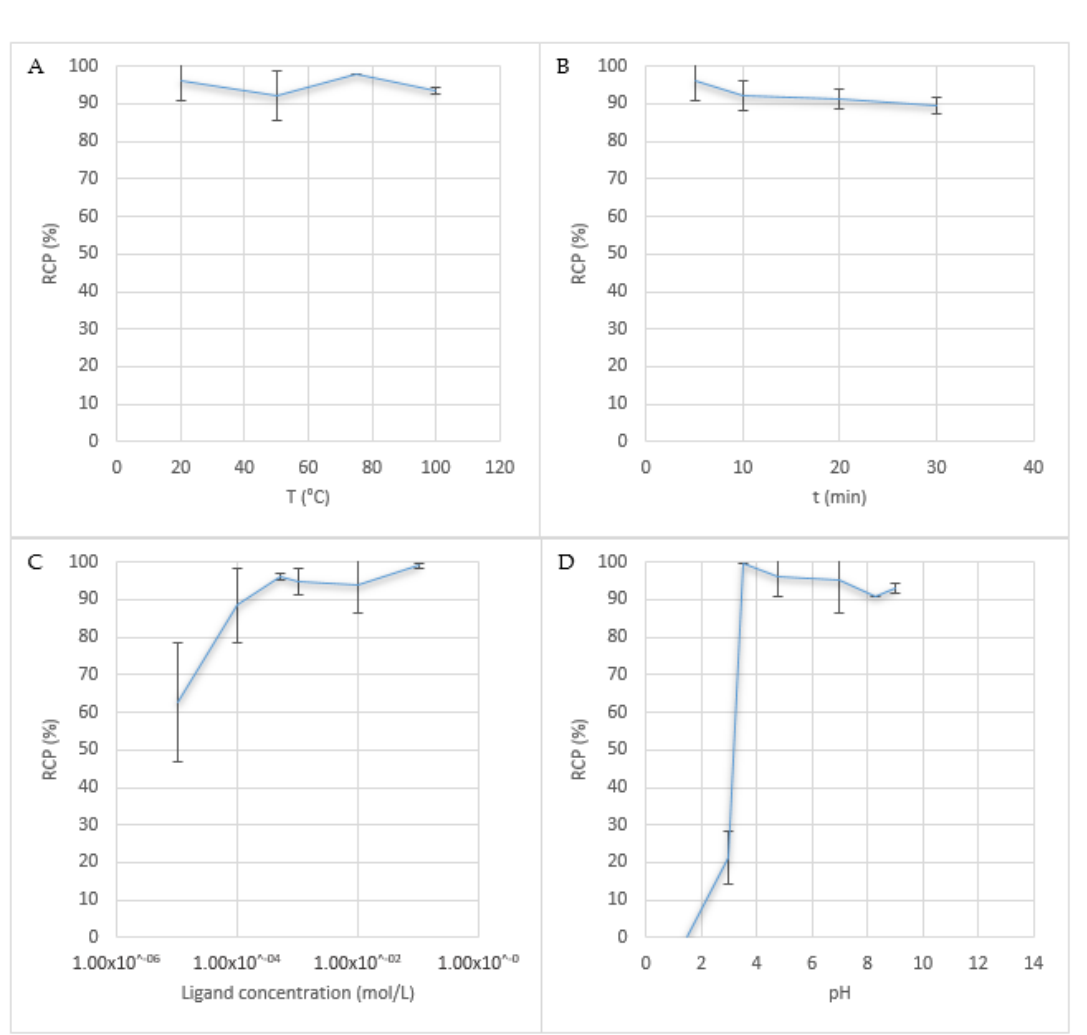
Figure 2. Influence of the reaction conditions. ( A ) Temperature, ( B ) Time, ( C ) Ligand concentration and ( D ) pH.